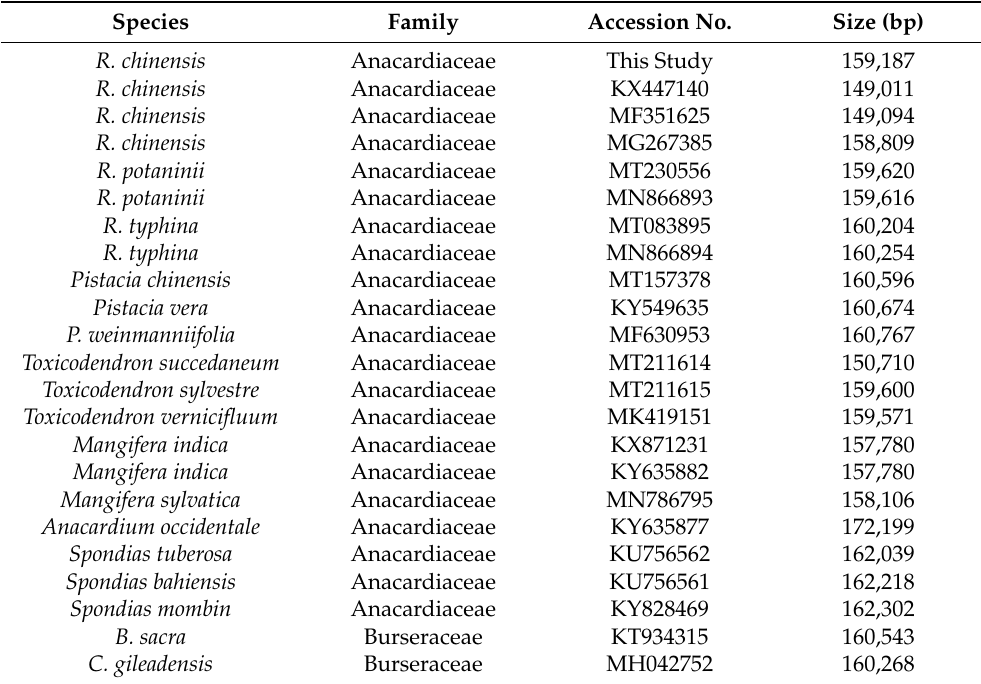
Table 1. Information of complete chloroplast genomes of Anacardiaceae species used in this study. Species